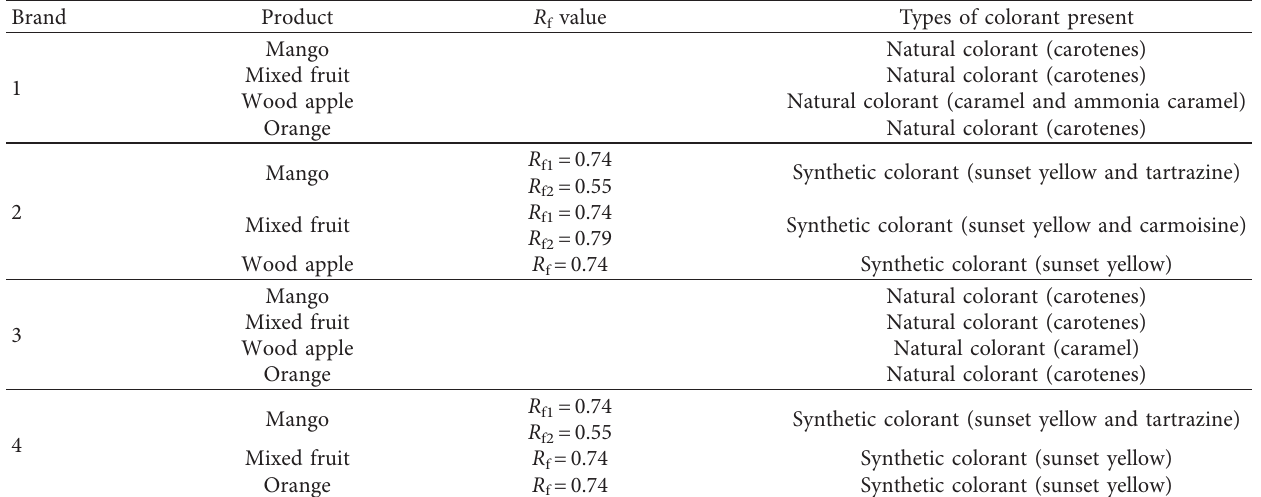
Table 4: Different types of synthetic and natural colorants present in fruit nectar samples.